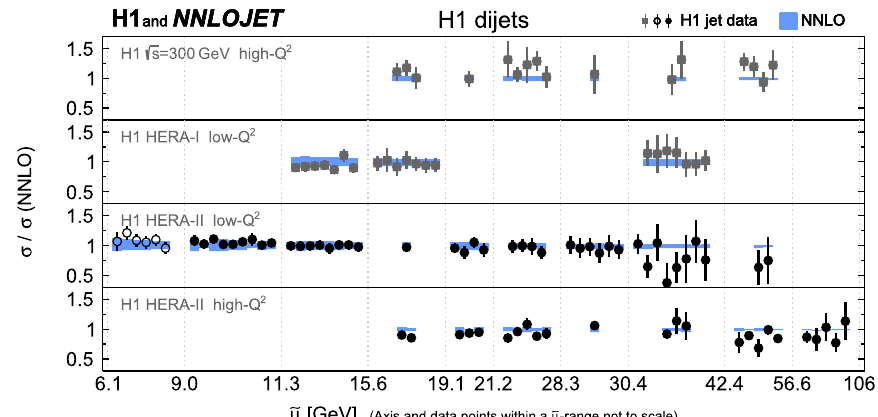
Fig. 12 Ratio of inclusive jet (upper panel) and dijet cross sections (lower panel) to NNLO predictions obtained with the fitted value α s ( m Z ) = 0 . 1157. Data points are ordered according to their scale ˜ μ and are displayed on the horizontal axis within the respective ˜ μ -interval. Within a single interval multiple data points are displayed with equal horizontal spacing and are thus not to scale. The displayed intervals reflect the choices made for the studies of the running of the strong coupling (compare Figs. 13 and 14). The shaded area indicates the uncertainty on the NNLO calculations from scale variations. The open circles show data points which are not considered for some fits, because their scale ˜ μ is below 2 m b . The squares show data points not considered for the ‘H1 jets’-fit, since the statistical correlations to the respective inclusive jet measurements are not known